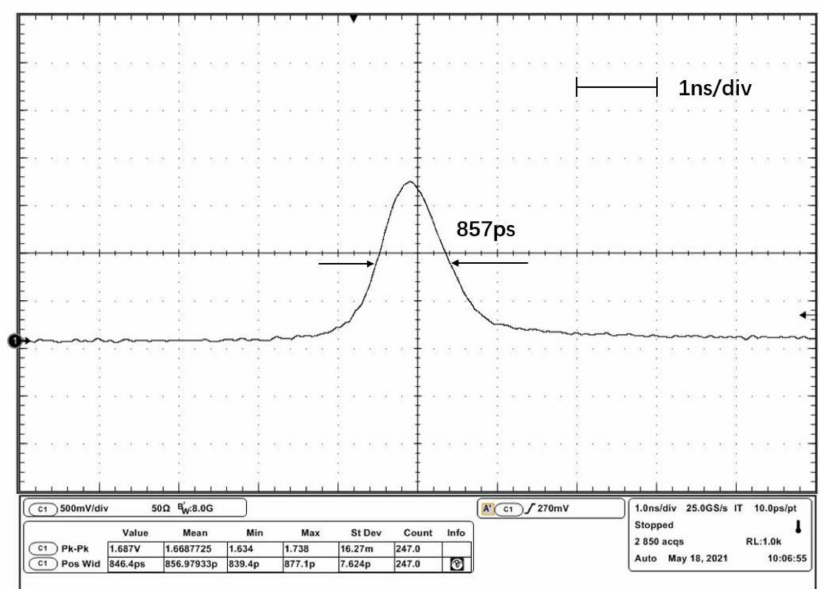
Figure 3. The single-pulse profile and pulse width of the seed.